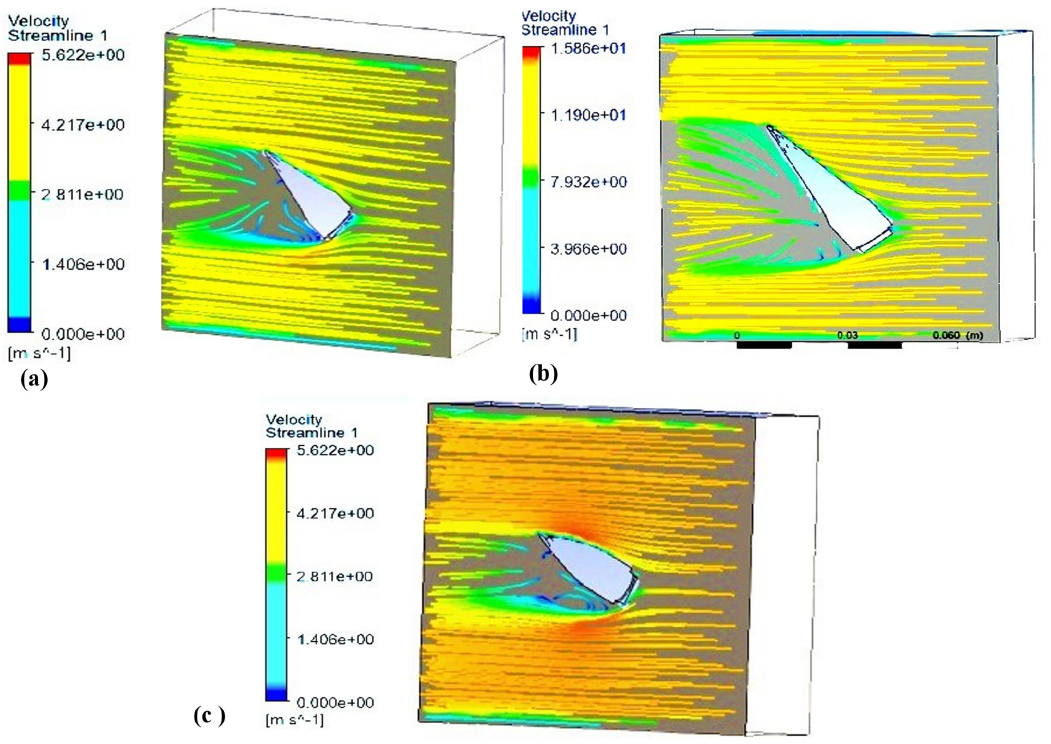
Figure 15. Velocity streamlines of ( a ) design I (30 mm) of bullet head at 30° angle of attack, ( b ) design I (40 mm) of bullet heat at 40° angle of attack, and ( c ) design II (30 mm) of bullet head at a 30° angle of attack.